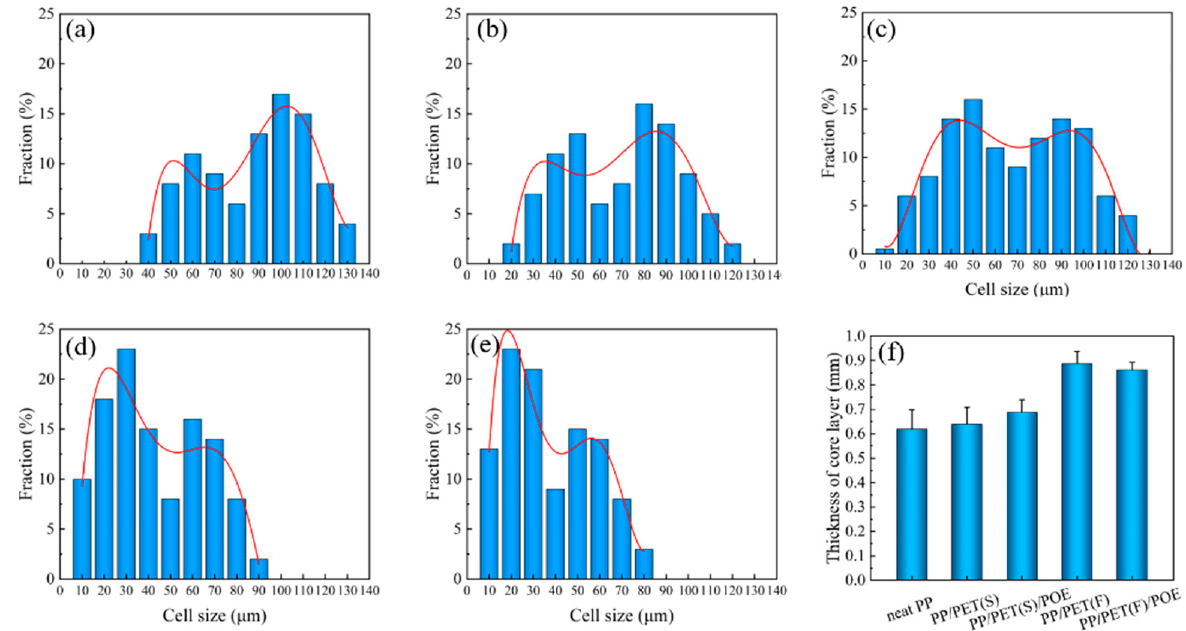
Figure 10. Cell size distribution of vertical sections: ( a ) neat PP, ( b ) PP/PET(S), ( c ) PP/PET(S)/POE, ( d ) PP/PET(F), ( e ) PP/PET(F)/POE; ( f ) thickness of core layer. Table 3. Statistical results of cell size and cell density at different layers in all